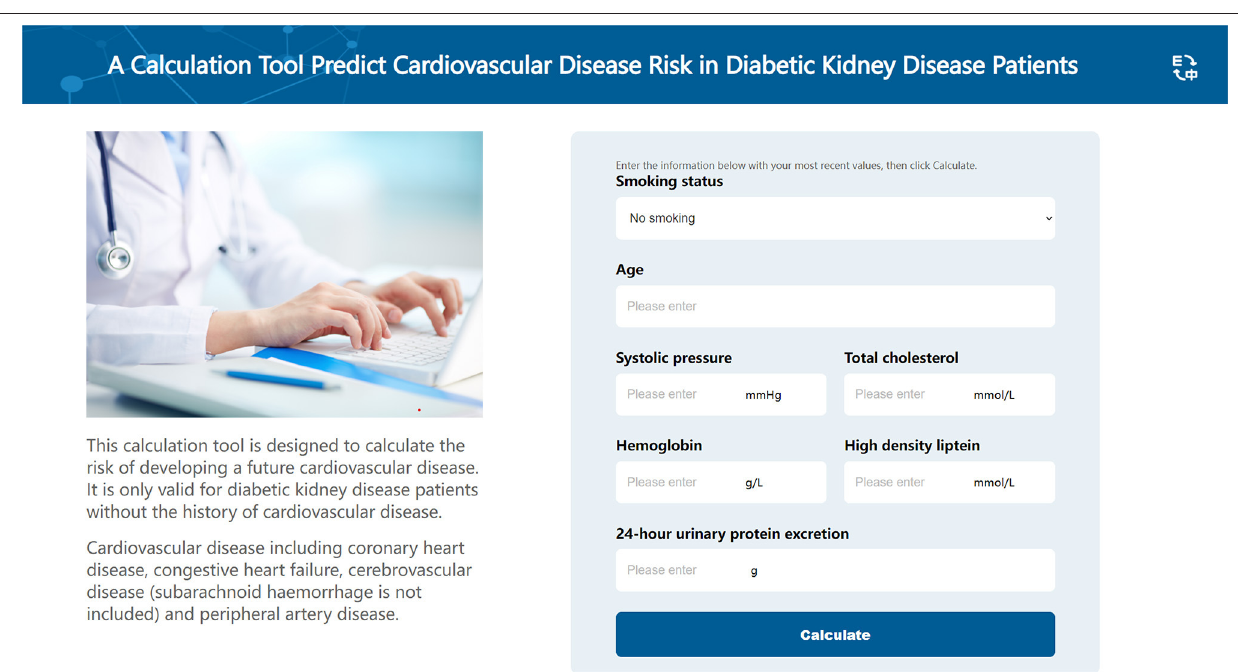
Frontiers in Cardiovascular Medicine | www.frontiersin.org